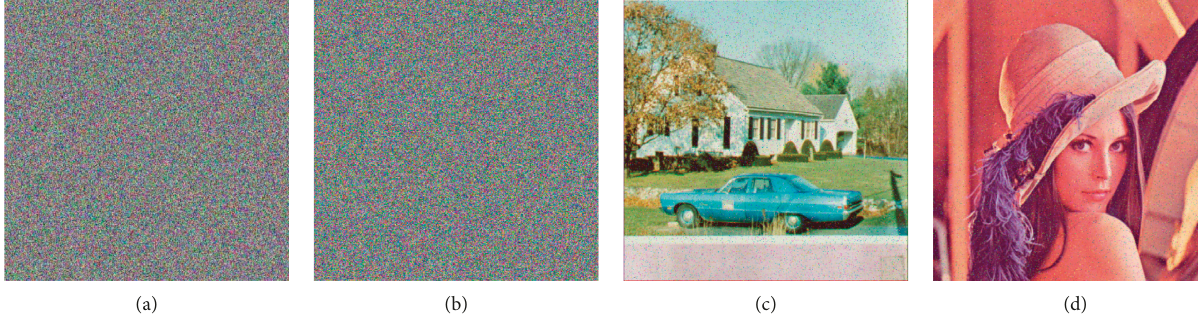
Figure 7: Salt-and-pepper noise attack.